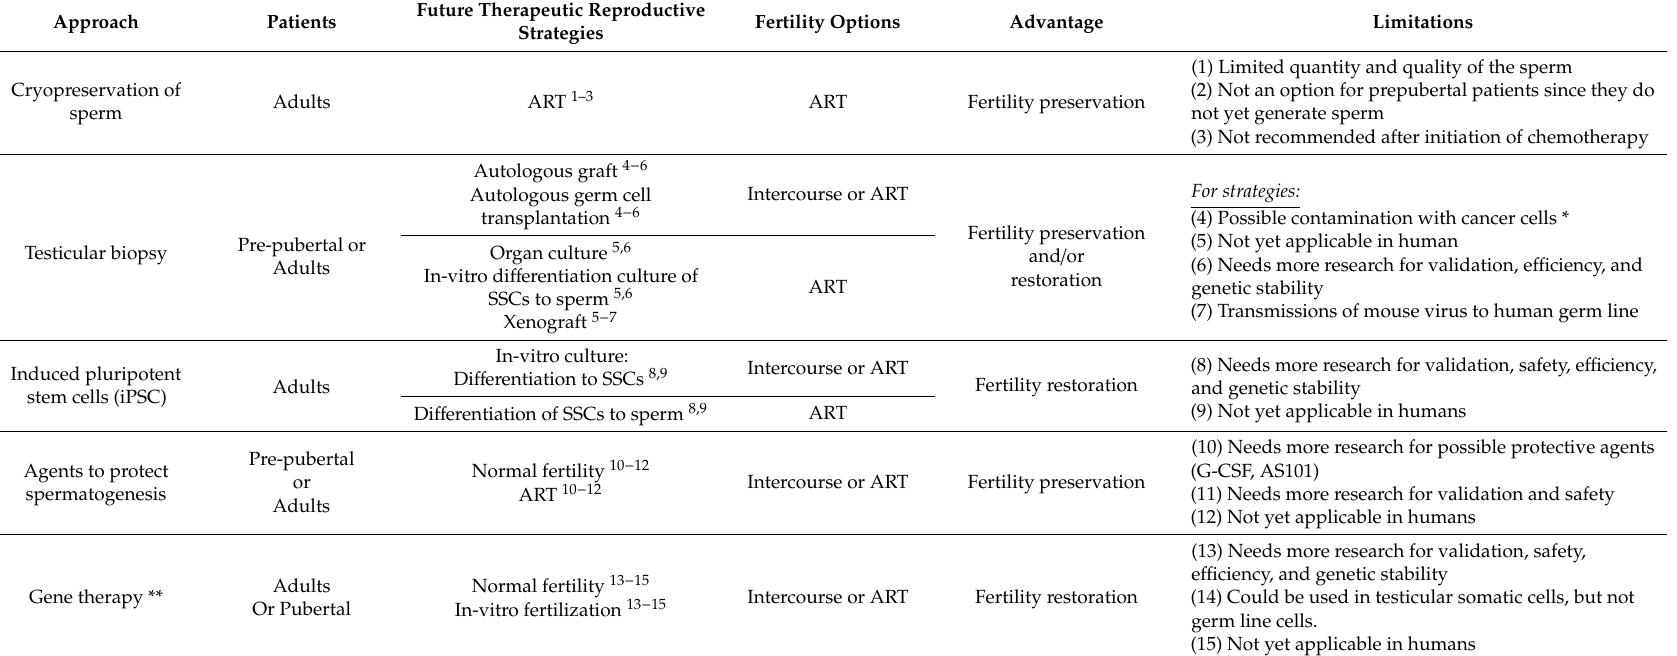
Table 1. Options for fertility preservation and restoration in